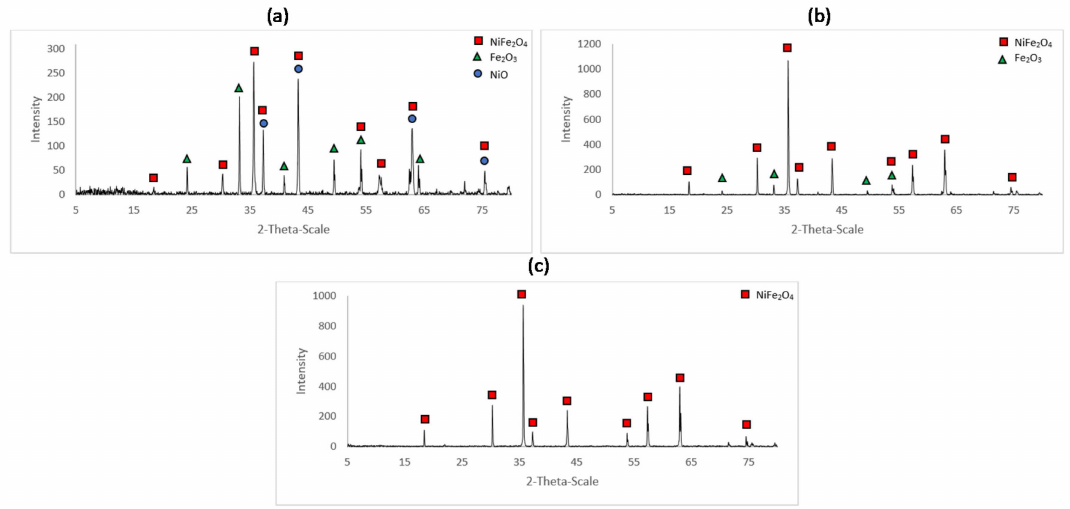
Figure 3. XRD spectrum for the ( a ) sample A_1 (600 ◦ C for 48 h), ( b ) sample A_2 (800 ◦ C for 48 h) and ( c ) sample A_3 (1000 ◦ C for 48 h).